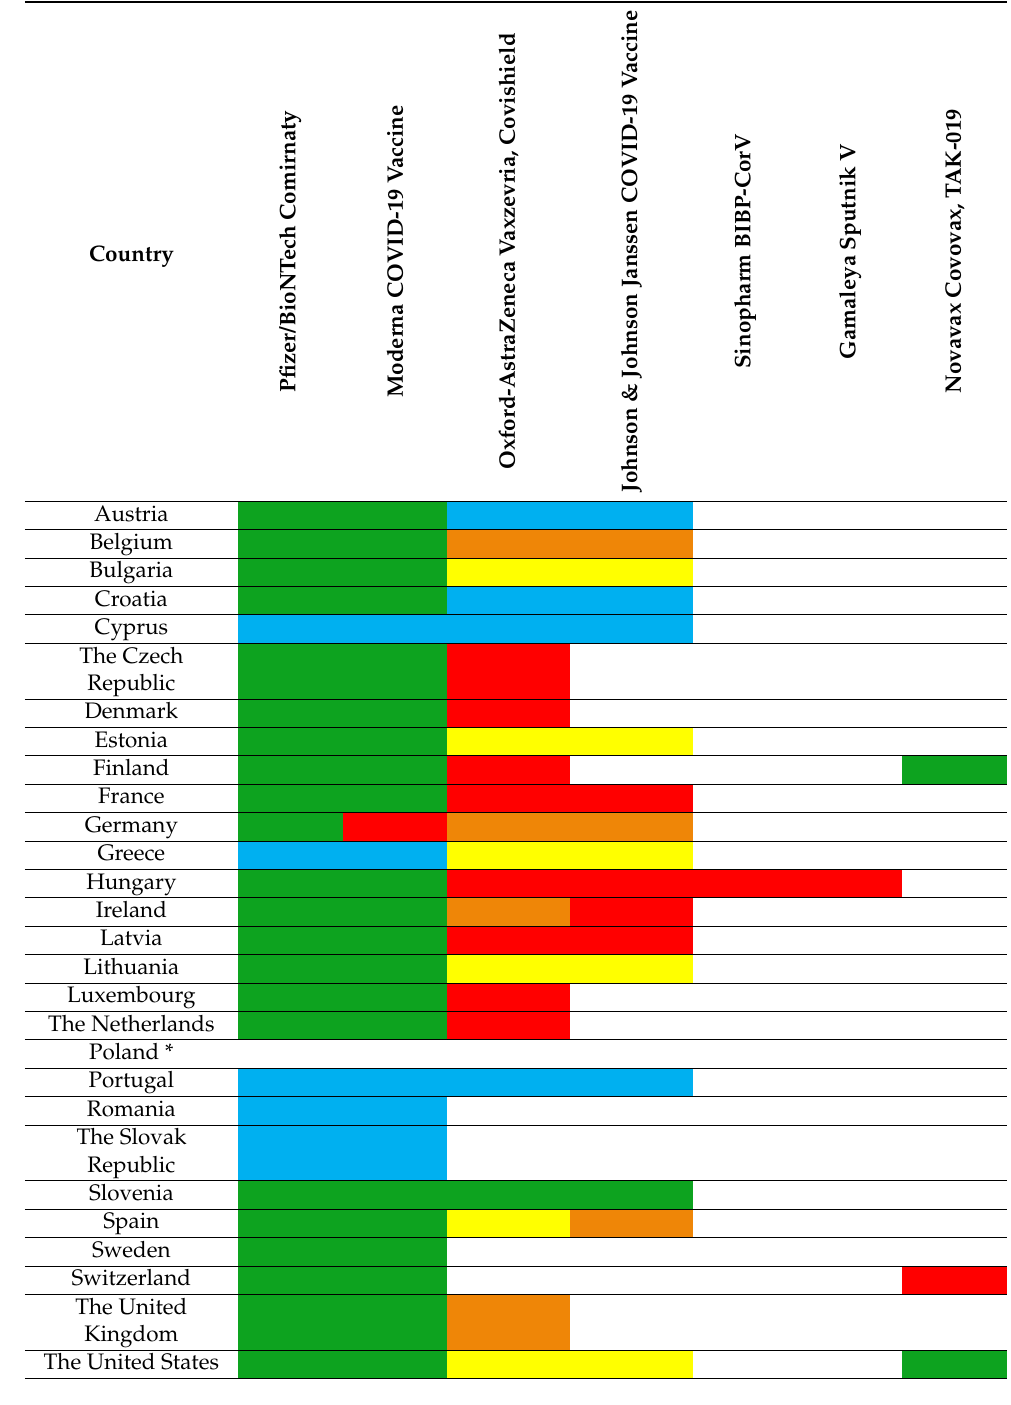
Table 1. Actual policy position for vaccination during pregnancy, by country (Europe, United Kingdom, United States), for each